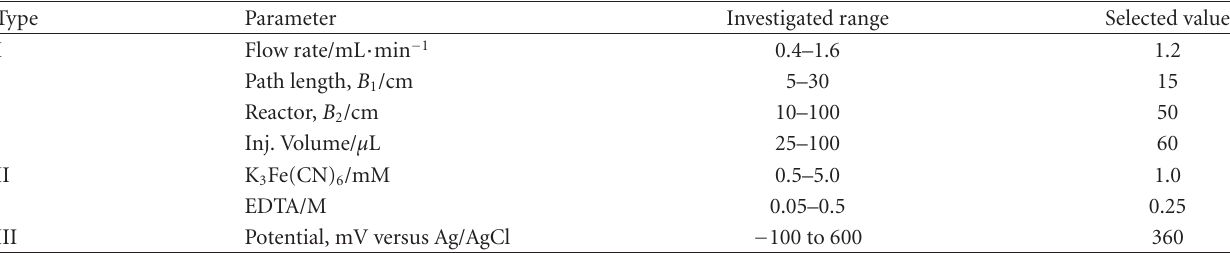
Table 1: Optimization of